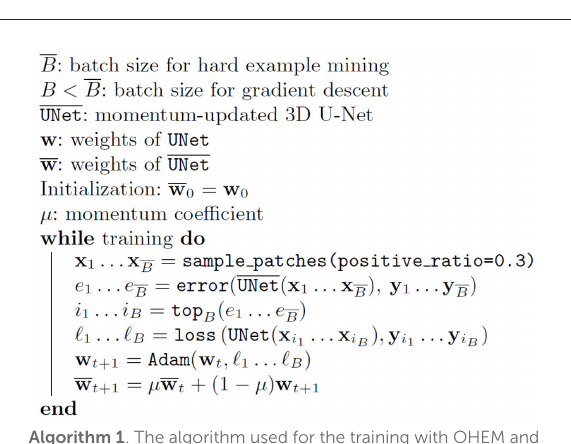
Algorithm 1 . The algorithm used for the training with OHEM and momentum